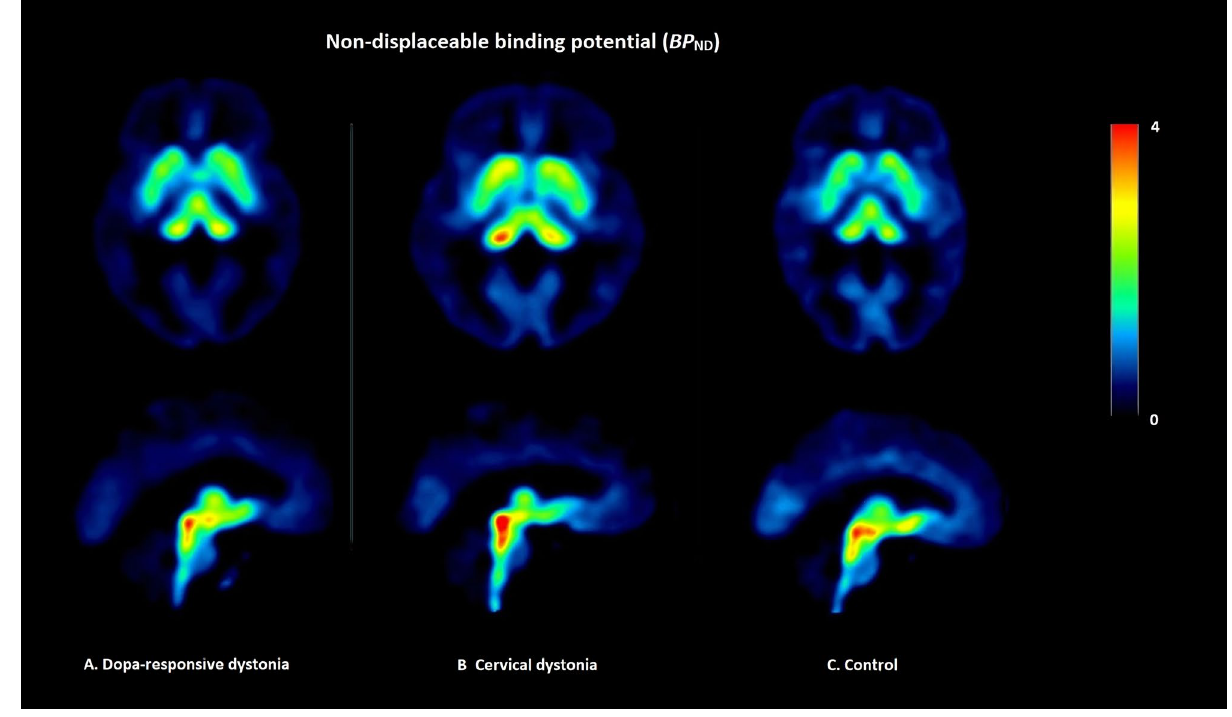
Figure 1. Non-displaceable binding potential ( BP ND ). Example of the non-displaceable binding potential of [ 11 C]DASB in a dopa-responsive dystonia (DRD) patient, a cervical dystonia (CD) patient and a control participant without a movement disorder. The DRD patient had dystonia for 43 years, was diagnosed with a panic disorder and had sleep disturbances; the CD patient suffered from dystonia for 52 years, was diagnosed with depression and panic disorder and was easily fatigued, the healthy control had no history of a psychiatric disorder and or sleep disturbance.